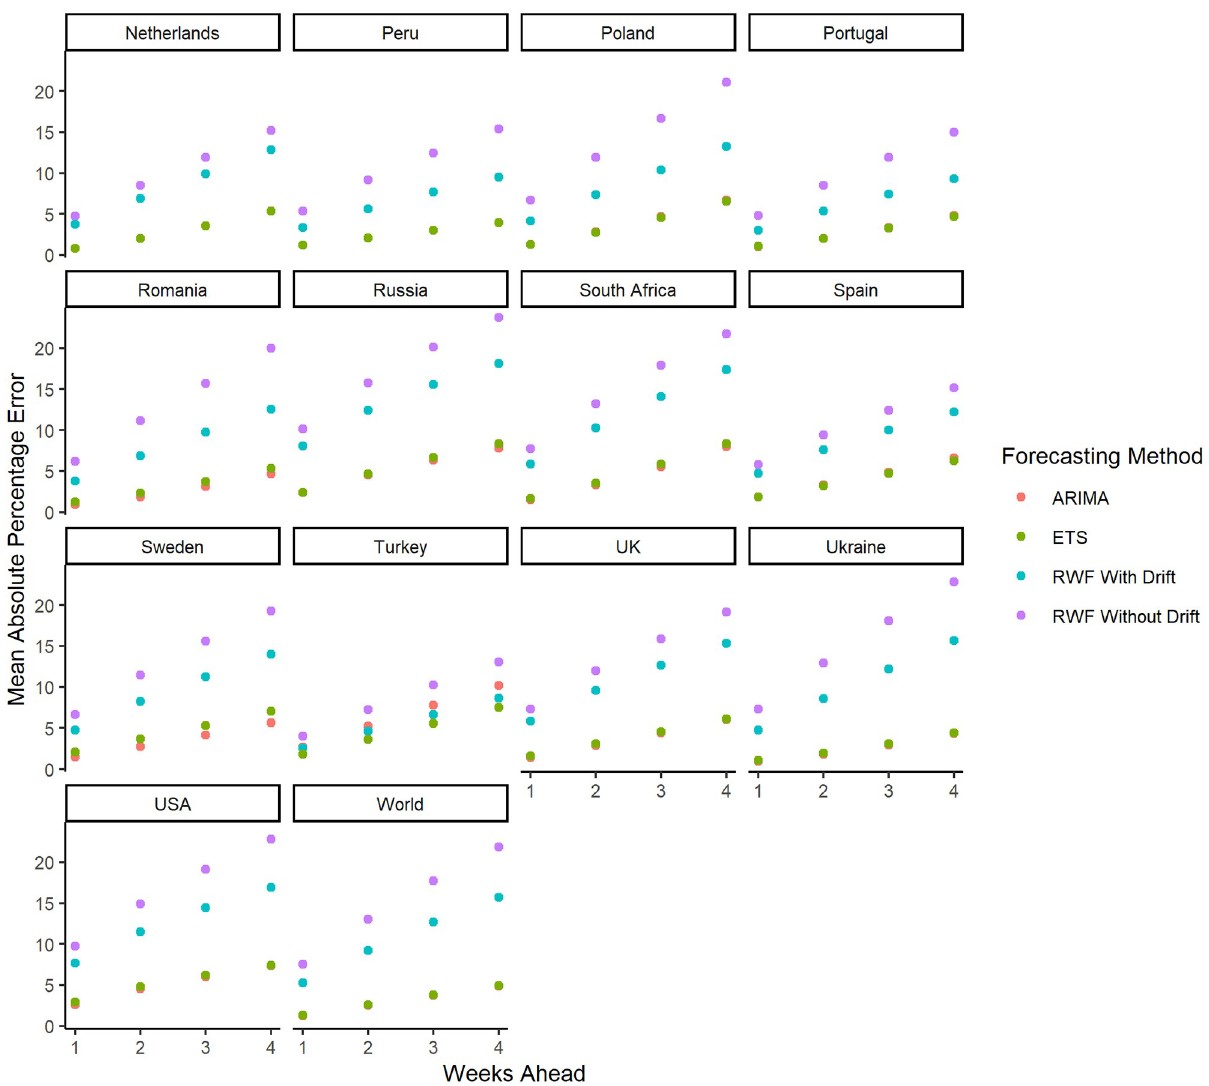
Fig 2. The MAPE for the forecasted values for 13 of the 29 countries with the highest cumulative COVID-19 cases and at the aggregated level for the entire world.